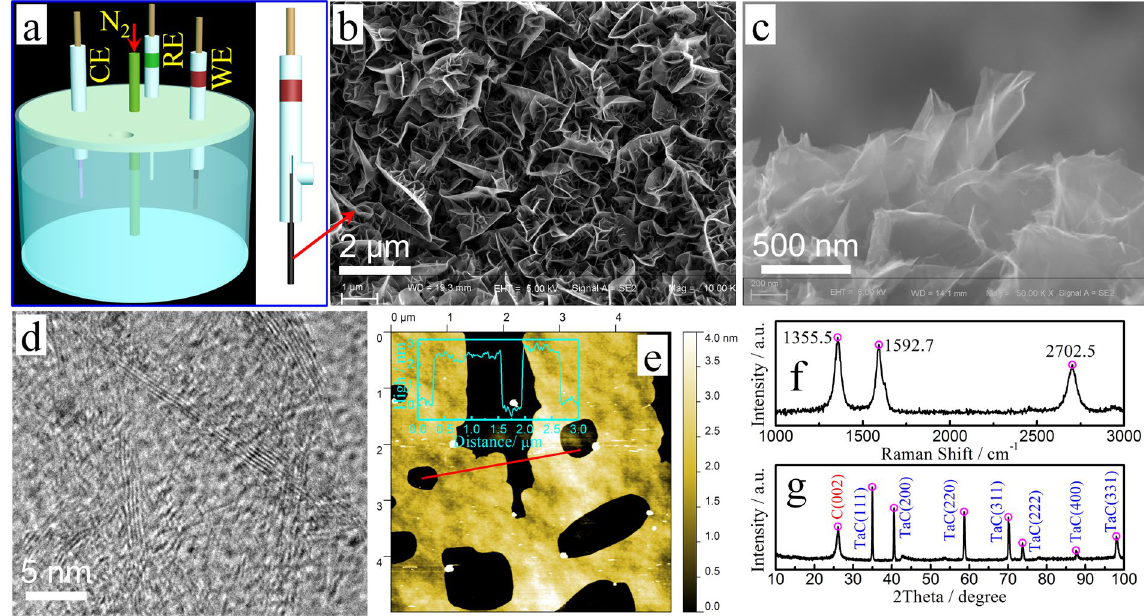
Figure 1. ( a ) Schematic diagram of electrolytic cell and electrodes. Dissolved oxygen was removed by passing N 2 into the electrolytic cell. Counter electrode (CE), reference electrode (RE), and working electrode (WE) are platinum sheet, saturated calomel electrode, and graphene/Ta wire, respectively. ( b ) Top-view and ( c ) cross- sectional SEM images of graphene nanosheets. ( d ) High-resolution TEM image of graphene nanosheets. ( e ) AFM image of graphene nanosheets. ( e ) Inset showing height profile along line. ( f ) Raman spectrum and ( g ) XRD pattern of graphene/Ta